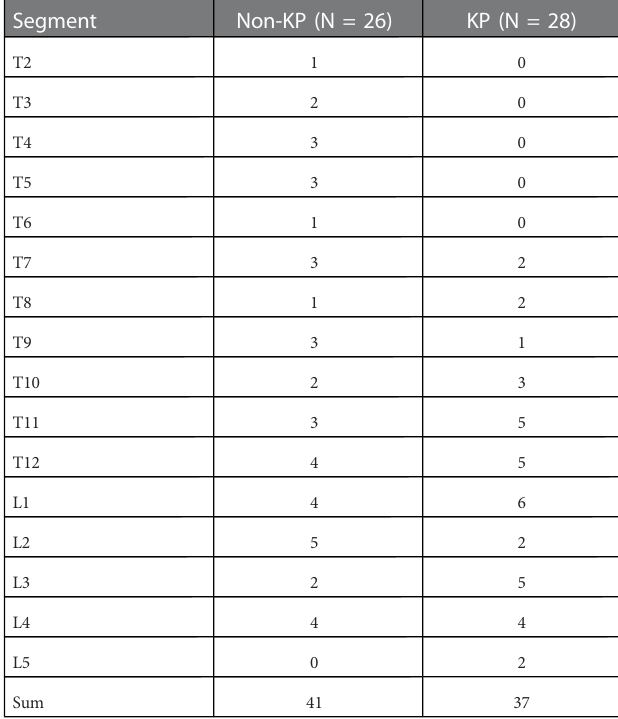
TABLE 2 Fractured segments of the patients